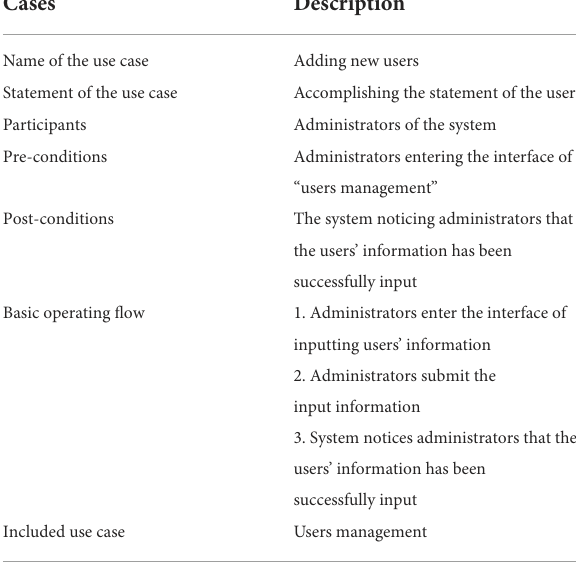
TABLE 1 Use case table for “users